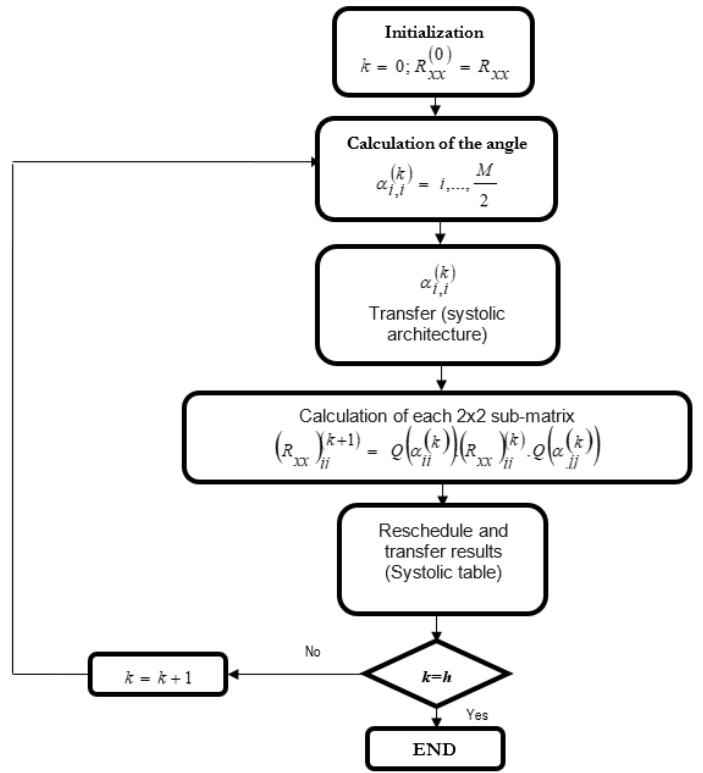
Figure 4. Flowchart for the calculation of eigenvalues by 2 × 2 sub-matrices by Jacobi’s method.